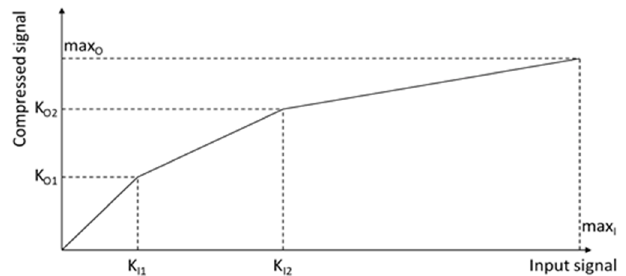
Figure 1. Piecewise linear representation in HDR image sensors.